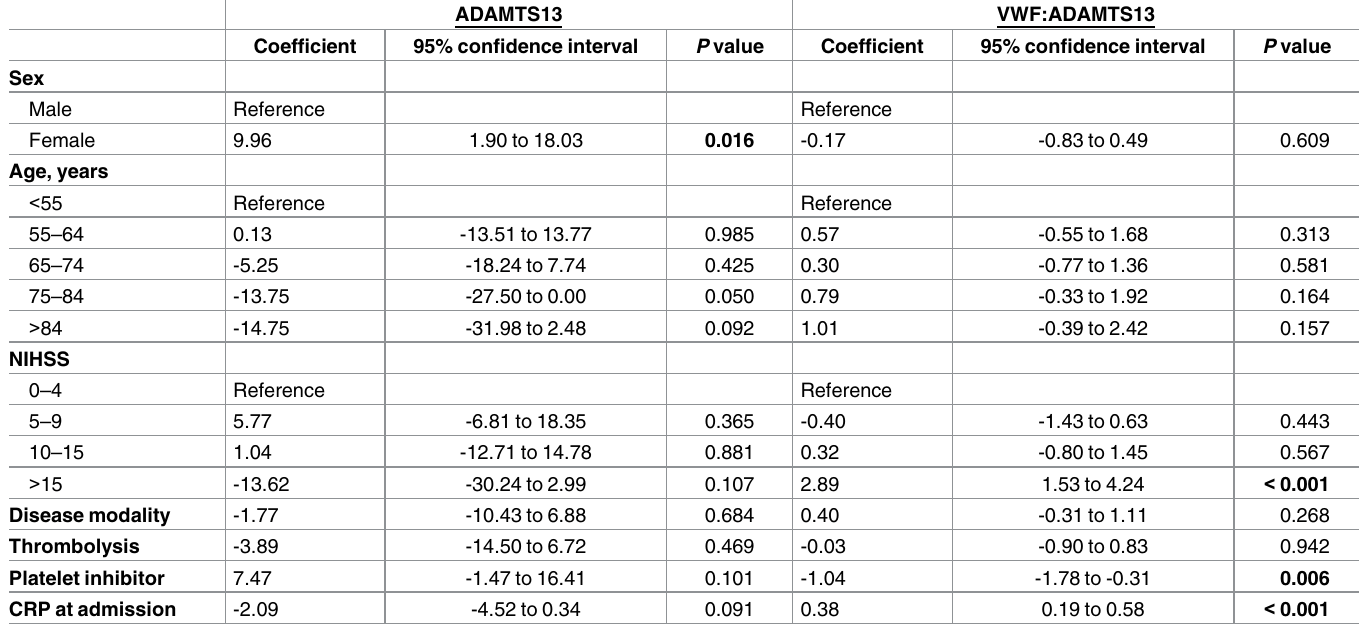
Table 3. Multivariate analysis of ADAMTS13 levels and the VWF:ADAMTS13 ratios with demographic and clinical